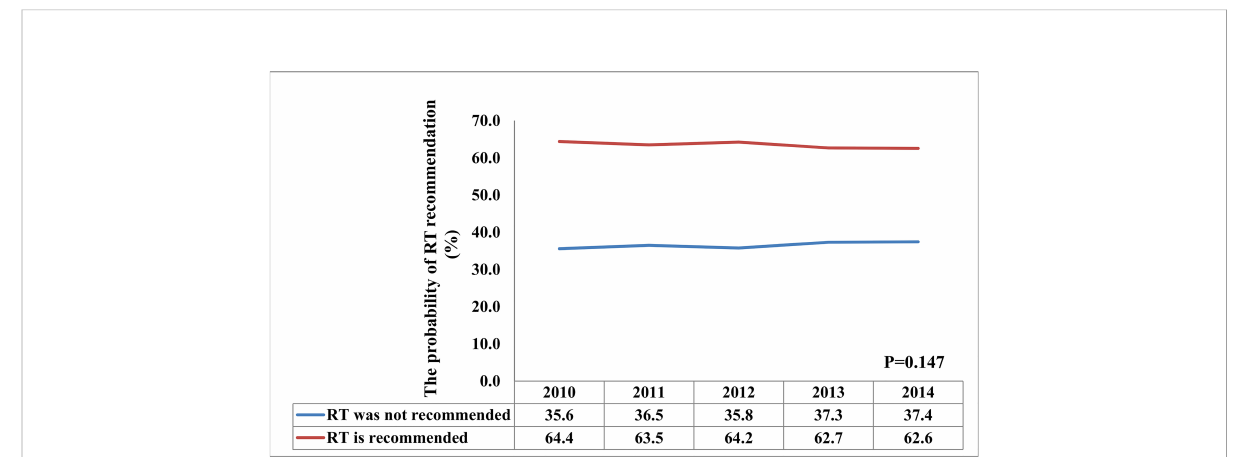
FIGURE 2 The proportion of patients with and without adjuvant radiotherapy between 2010 and